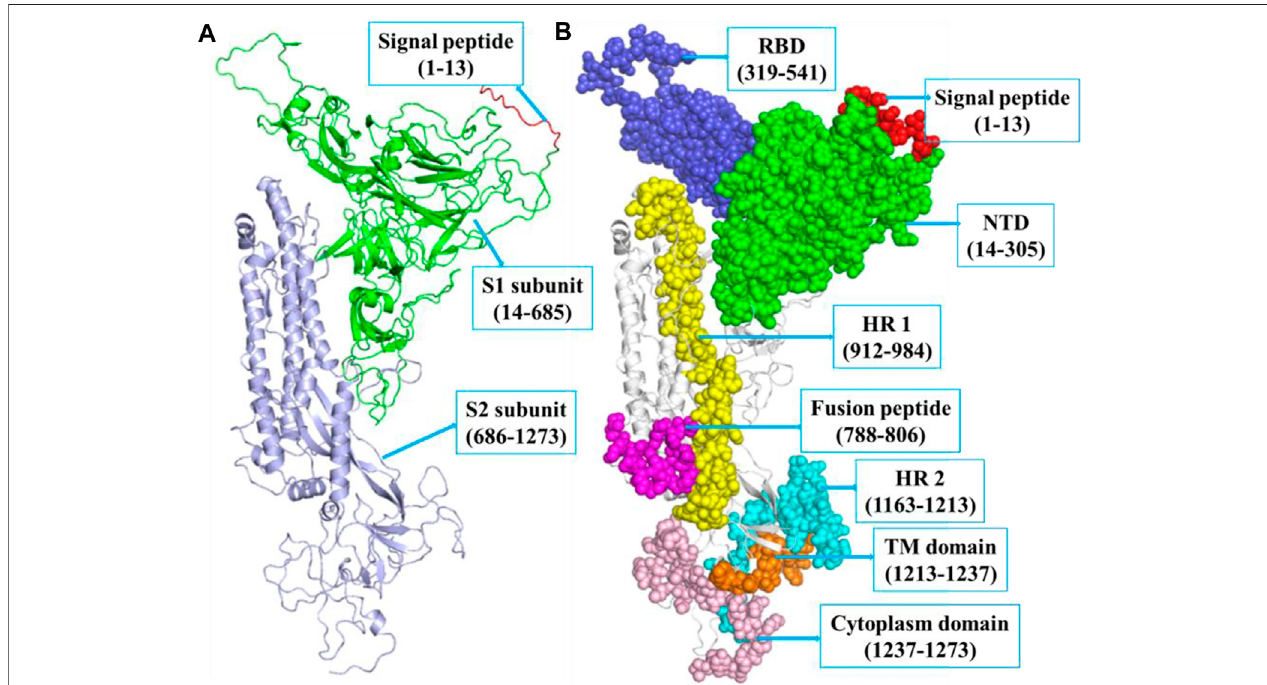
FIGURE1|(A) Thestructure ofSARS-CoV-2spike protein indicatingSP(red, 1 – 13 aa ),S1(green,14 – 685 aa ),and S2(blue, 686 – 1,273 aa ),respectively. (B) The S1subunitincludesNTDdomain(green,14 – 305 aa )andRBD(blue,319 – 541 aa ).TheS2subunitincludesFP(magenta,788 – 806 aa ),hepta-peptiderepeatsequence1 (yellow, 912 – 984 aa ), hepta-peptide repeat sequence 2 (cyan, 1,163 – 1,213 aa ), TM domain (orange, 1,213 – 1,237 aa ), and cytoplasm domain (pink, 1,237 – 1,273 aa ),